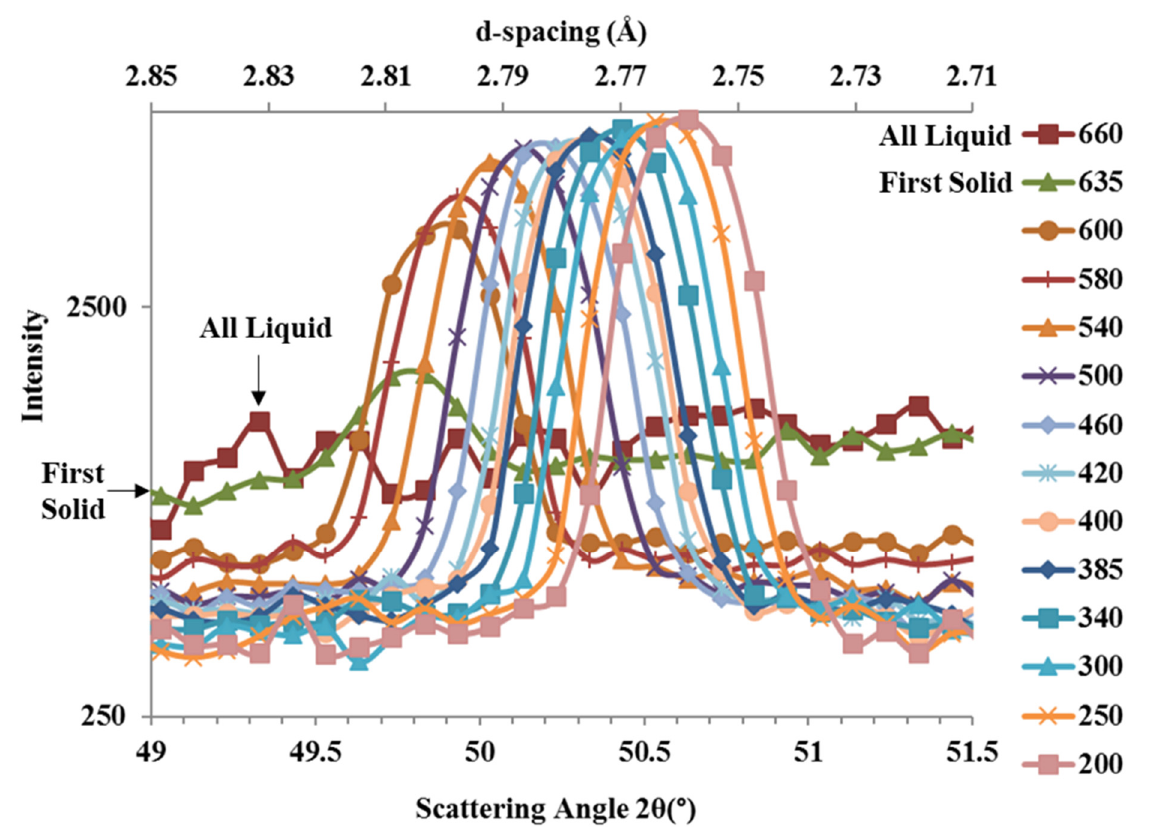
(cid:0) (cid:1) 1010 plane at different temperatures